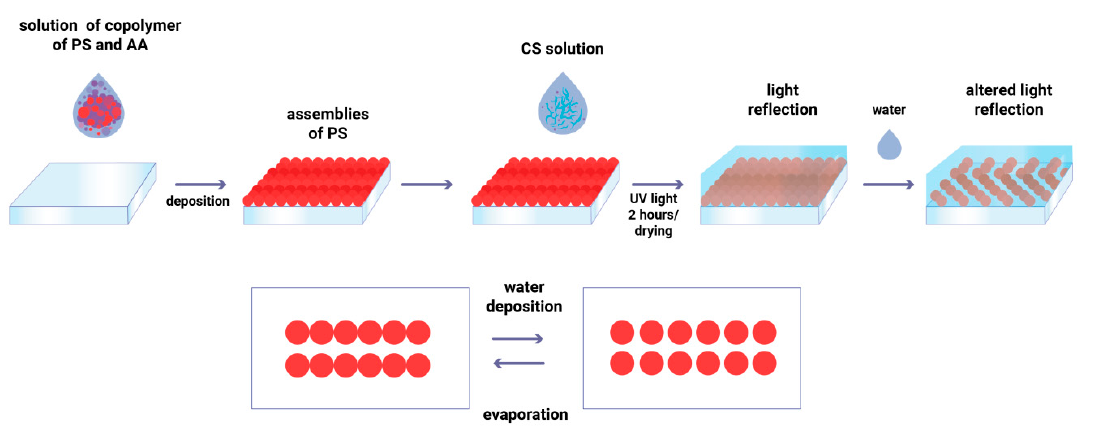
Figure 7. The photos of printed PS colloid on a silicon wafer ( A ), the PS–CS hydrogel before humidity changes ( B ) image appearance after water addition ( C ), and hydrogel after complete drying ( D ). ( E ) Schematic illustration of the process of image appearance after water interaction. The photos of a